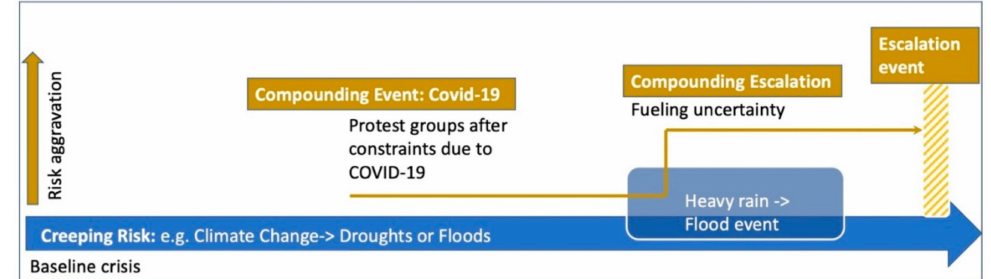
Figure 6. Social compounding event due to COVID-19 upon an ongoing flood